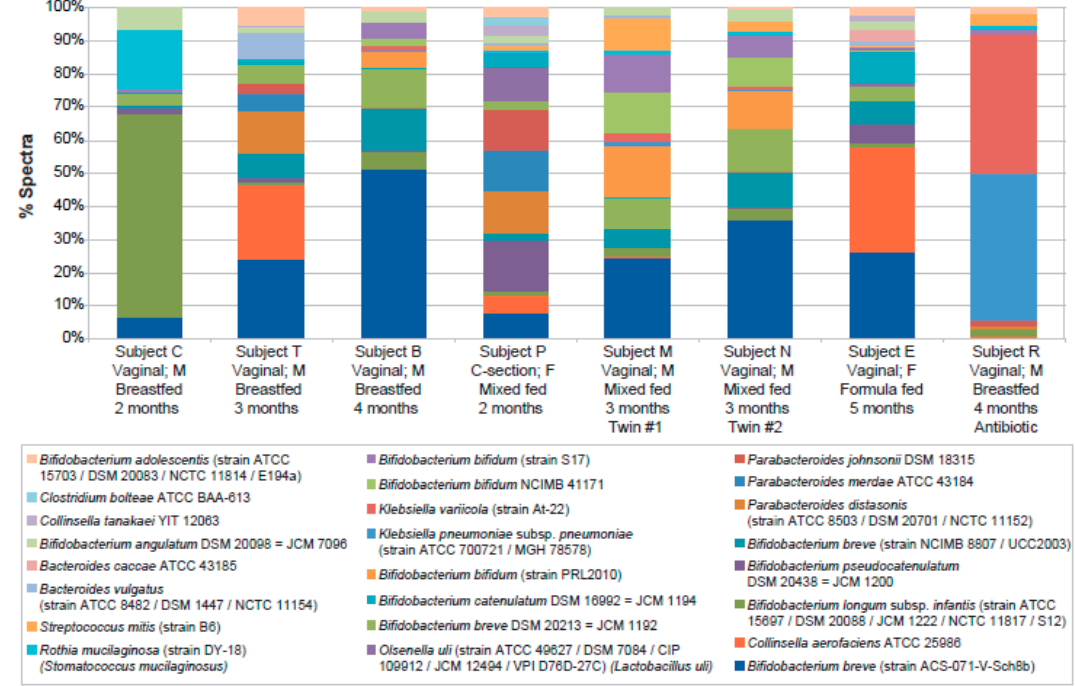
Figure 3. Relative strain-level abundance per infant as detected by metaproteomics. Included are the 24 strains represented by at least 20 spectra in at least one infant.